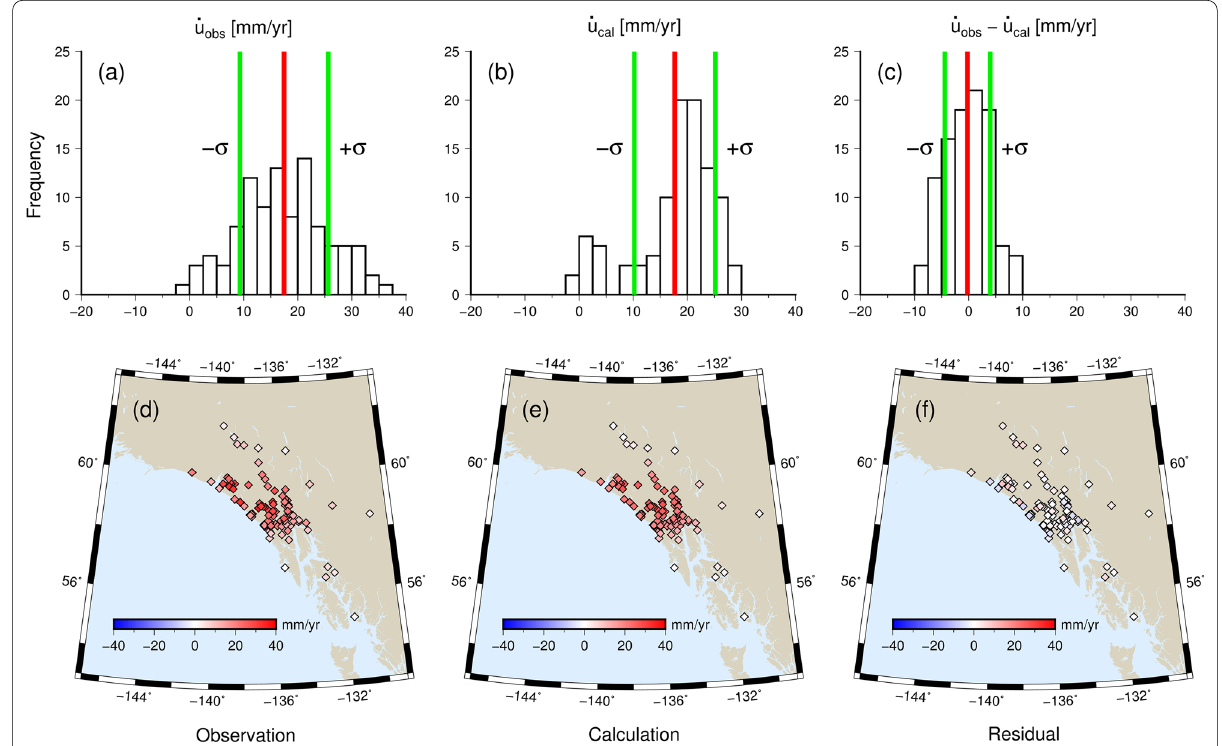
Fig. 10 Vertical ground deformation rates for 99 GNSS stations in SE-AK. Panels a and d show the histogram and spatial distribution of the observed vertical ground deformation rates, respectively. Panels b and e show the histogram and spatial distribution of the vertical ground deformation rates calculated from our GIA model, respectively. Panels c and f show the histogram and spatial distribution, respectively, of the residual between the observed and calculated vertical ground deformation rates, respectively. In panels a – c , the red line and two green lines indicate the average and 1- σ error range,